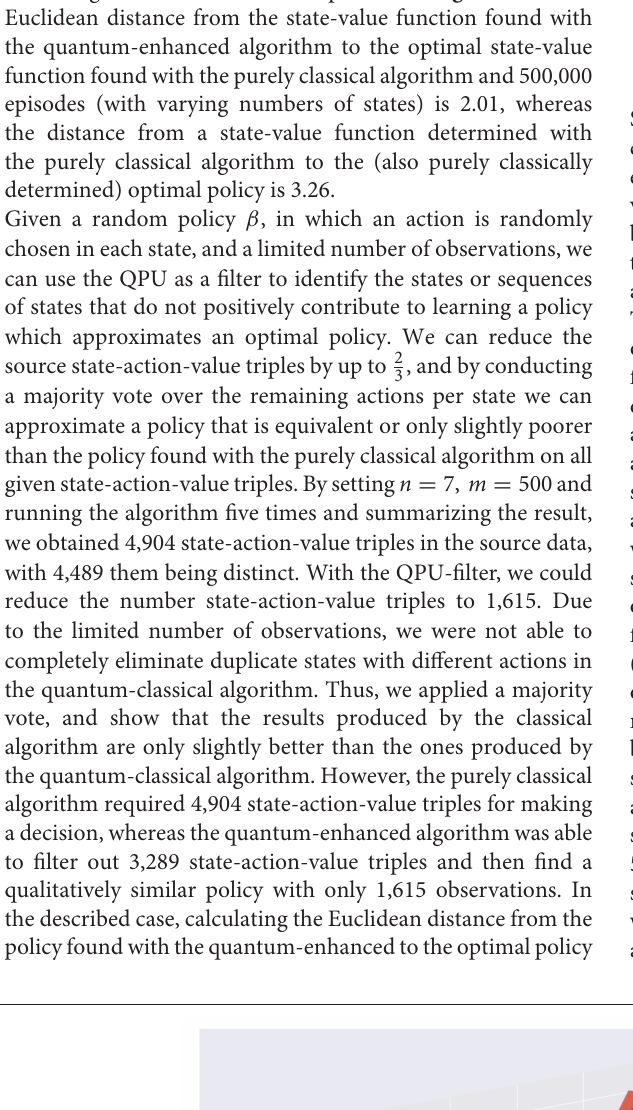
Frontiers in Physics |